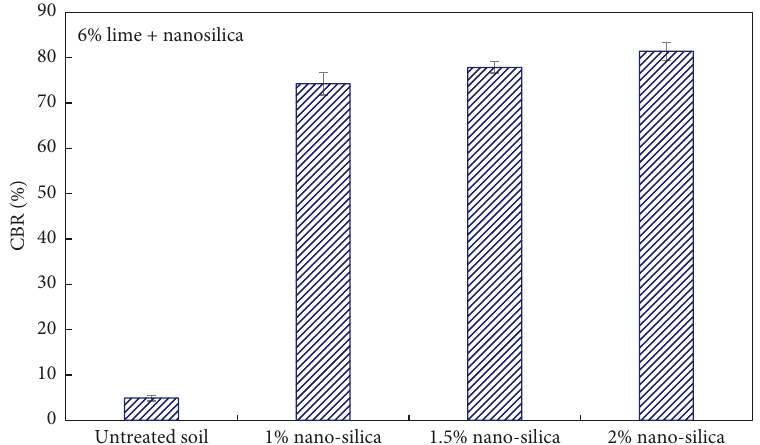
Figure 10: Effect of nano-SiO 2 on the CBR of lime-stabilized soil after 7days of